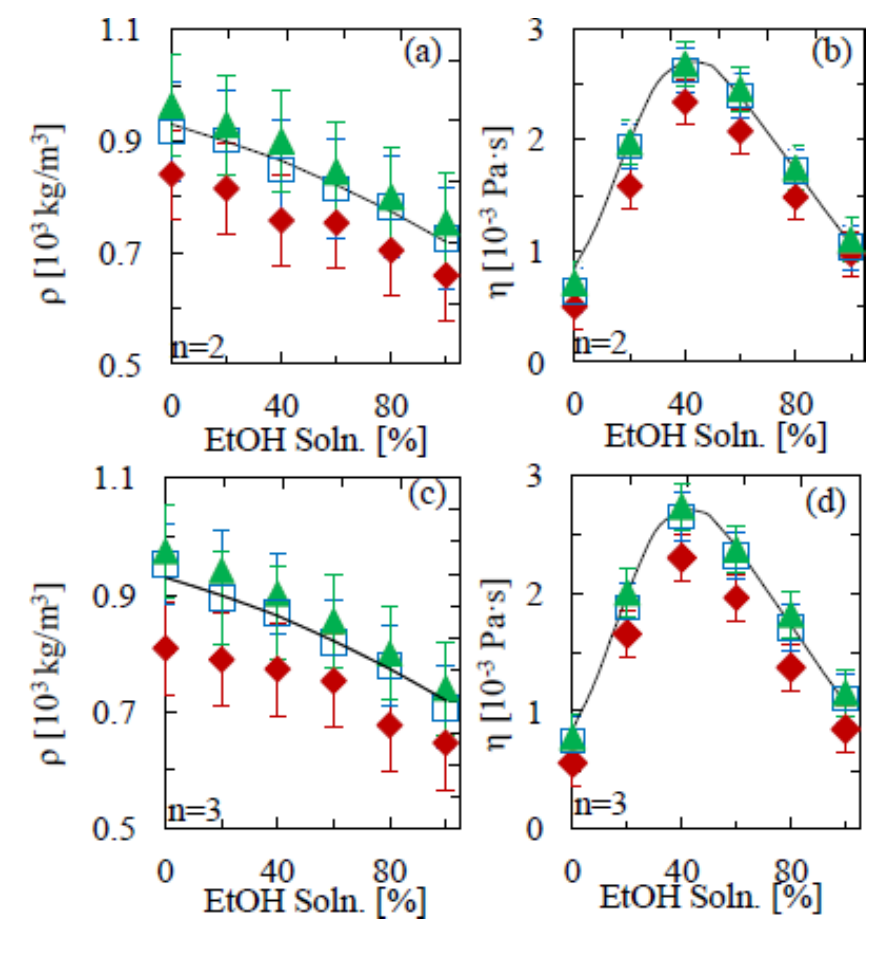
Figure 2. ( a ) Mass density and ( b ) viscosity of water-ethanol mixtures, as a function of ethanol volume percentage, determined from the second mode (n = 2) of flexural cantilever oscillation. ( c ) and ( d ) show the corresponding results for the third mode (n = 3) of oscillation. The solid line denotes the literature values [24] at 20 °C. Triangles, squares and diamonds denote aspect ratios of 13:1, 10:1 and 5:1,